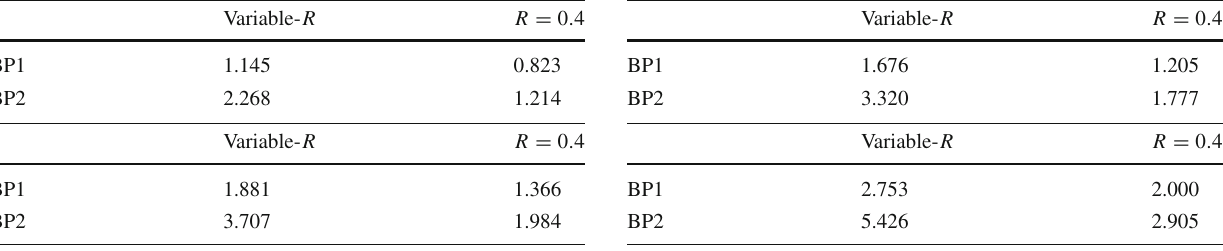
Table 3 Upper panel: final (cid:14) values calculated for signal and back- Table 4 Upper panel: final (cid:14) values calculated for signal and back- grounds for L = 140 fb − 1 upon enforcing the reduced cuts plus the grounds for L = 300 fb − 1 upon enforcing the reduced cuts plus the massselectioncriteria.Lowerpanel:final (cid:14) valuescalculatedforsignal massselectioncriteria.Lowerpanel:final (cid:14) valuescalculatedforsignal and backgrounds for L = 140 fb − 1 with K -factors upon enforcing the and backgrounds for L = 300 fb − 1 with K -factors upon enforcing the reduced cuts plus the mass selection criteria reduced cuts plus the mass selection criteria Variable- R R = 0 . 4 Variable- R R = 0 . BP1 1.145 0.823